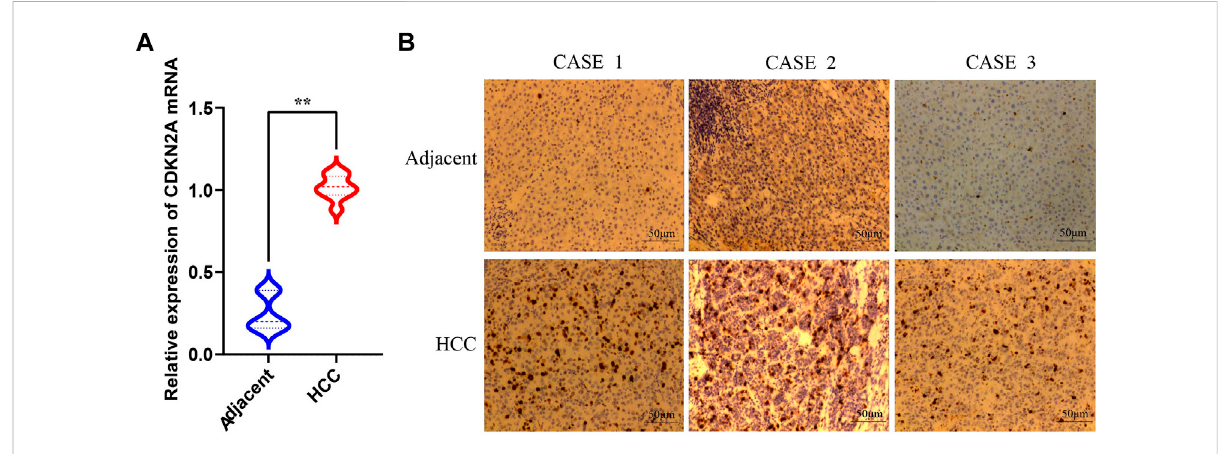
FIGURE 11 qRT-PCR and immunohistochemical of CDKN2A (A) Relative expression of CDKN2A mRNA in HCC and adjacent normal tissues. (B) Immunohistochemical of CDKN2A protein in HCC and adjacent normal